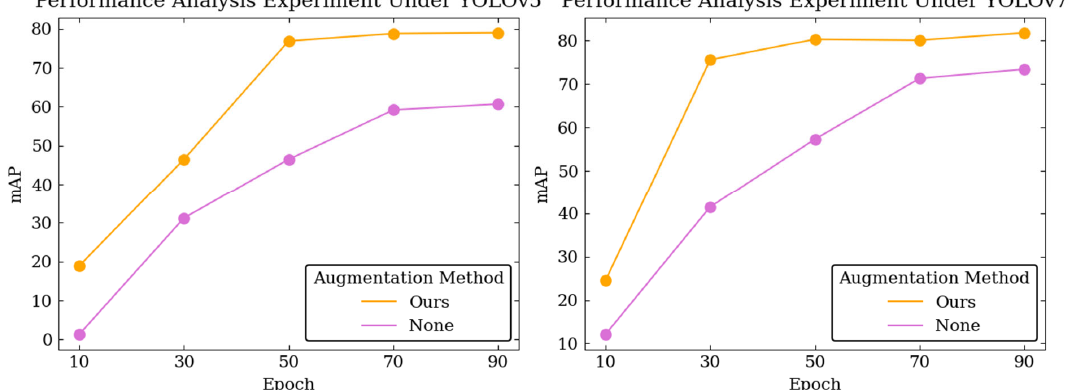
Figure 10. Comparison of model performance in different training epochs, where “Ours” denotes the